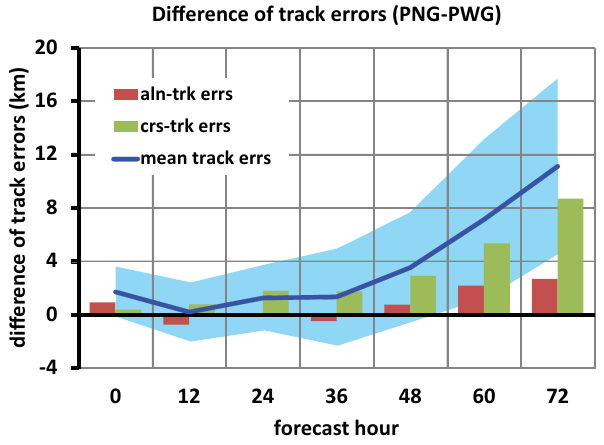
Figure 5. Difference between mean track errors, along-track errors and cross-track errors of PNG and